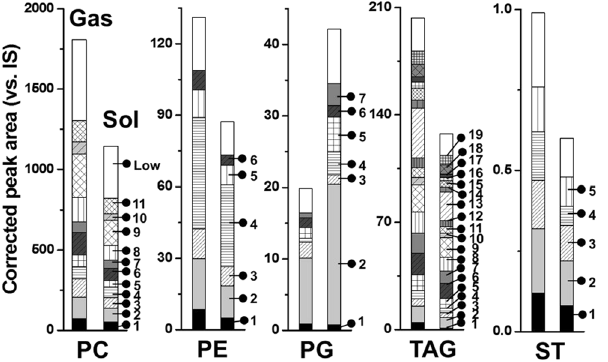
Figure 2. Comparison of total amounts of five lipid categories showing large differences between the Gas and Sol muscles in WT mice marked with the individual composition by nUPLC-ESI-MS/MS. Numbers representing individual molecules are relatively highly abundant species marked in Supplementary Table S2 and ‘low’ represent the summed amount of the species present in low amounts. Plots of the remaining 14 categories are presented in Supplementary Fig. S4.